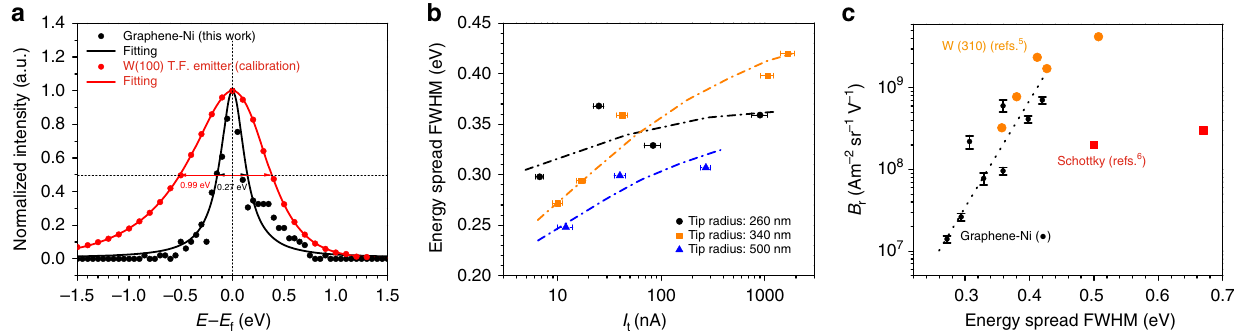
Fig. 5 Energy spread and its dependence on emission current and reduced brightness. a Electron energy distribution from a Graphene-Ni tip with a radius of 340 nm emitting at a total emission current of 10 nA and an angular current of 0.1 μ A sr − 1 . The pass energy and the dwell time for measurement are 10 eV and 0.1 s, respectively. The W(100) T.F. emitter was employed to calibrate to electron analyzer (Focus Electronics CSA 200). b Energy spread FWHM versus total emission current obtained from different tip sizes. The uncertainty in the x -axis (5 – 10%) is due to the current instability. c Reduced brightness versus energy spread and state-of-the-art electron sources. The uncertainty in the y -axis is from the determination of tip size and